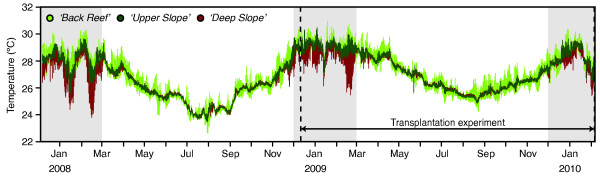
Temperature patterns in the three different habitats. Temperature records before and during the transplantation experiment. Warmest months (Dec-Mar) are indicated in grey, which is when the cold-water influxes occur in the 'Deep Slope' habitat.